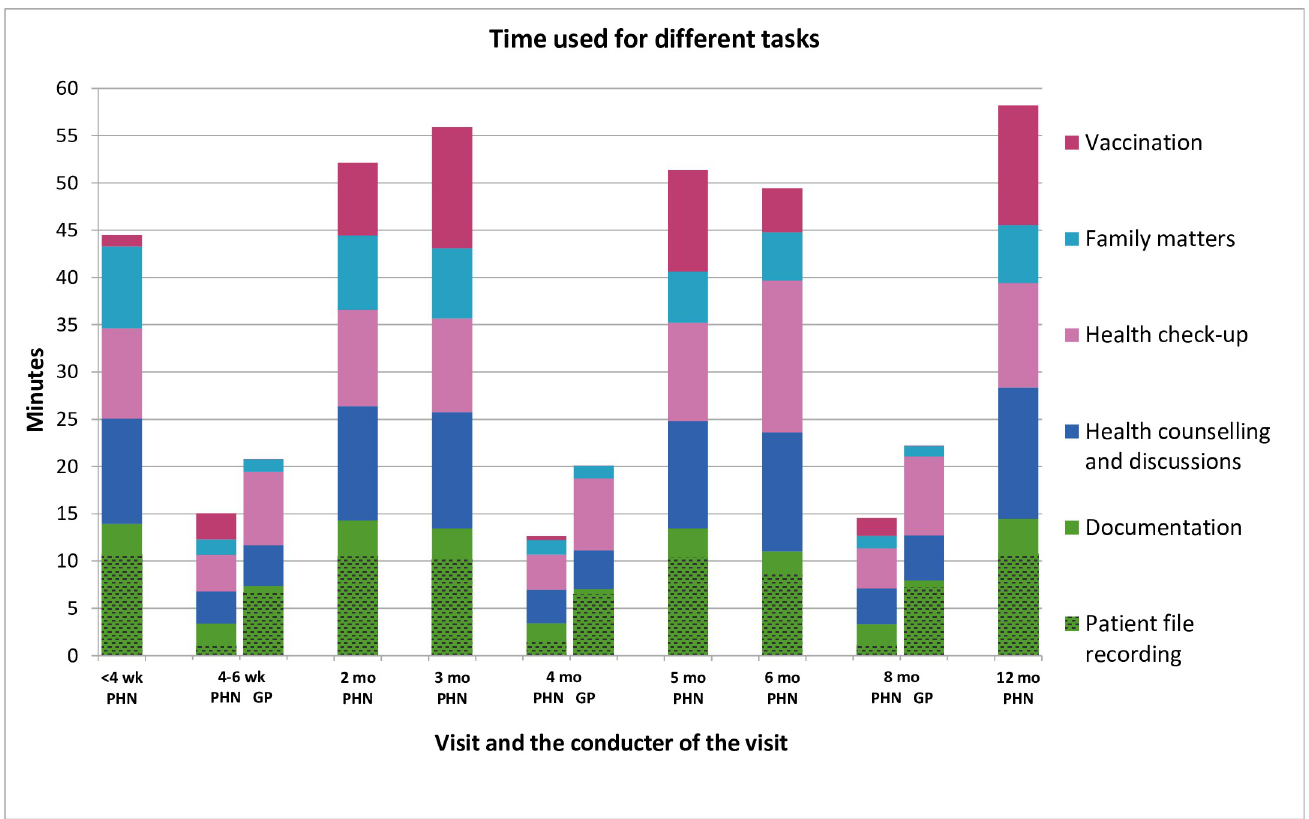
Fig 3. The time public health nurses (PHN) and physicians (GP) used for different task during the child’s visit to child-health-clinic. The tasks belonging to each task group are shown in Table 1. Note: recording patient file is included in the documentation task group.